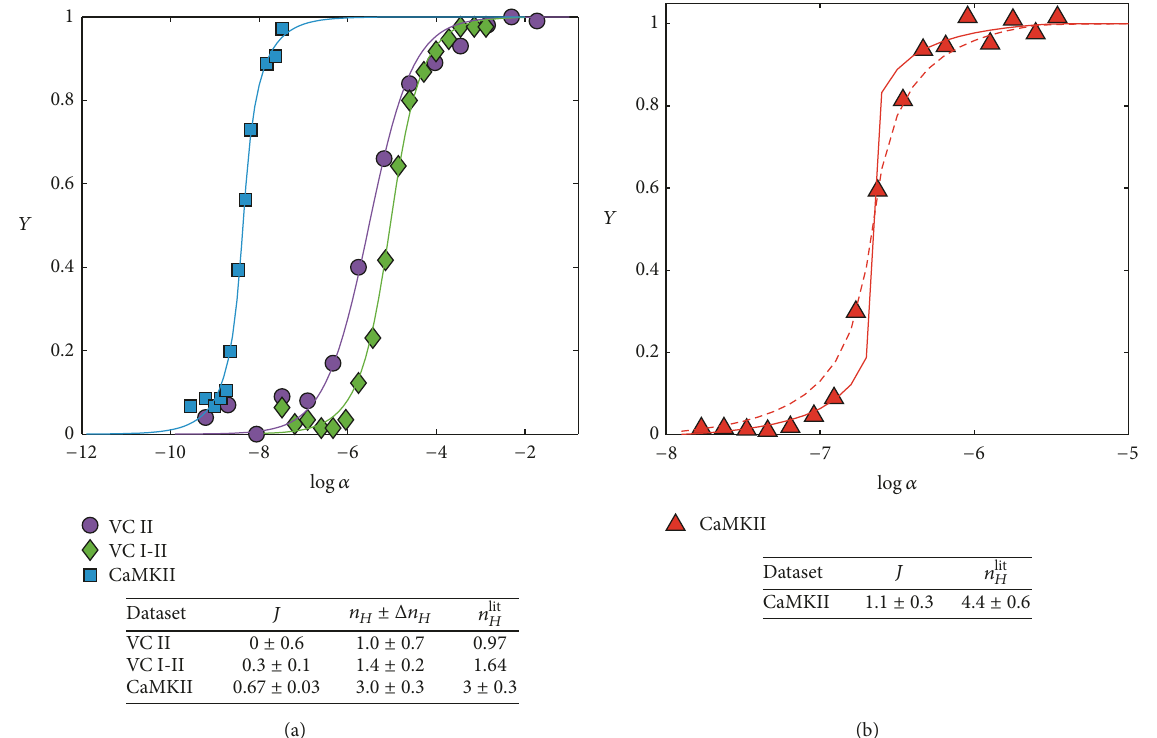
Figure 1: These plots show comparison between data from experiments (symbols) and best-fits through (22) (lines). Data refer to noncooperative and positive-cooperative systems [33, 34] (a) and an ultrasensitive system [35] (b). For the latter we report two fits: dashed line is the result obtained by constraining the system to be cooperative but not ultrasensitive (i.e., 𝐽 ≤ 1 ), while solid line is the best fit (without constraints) which yields to 𝐽 ∼ 1.1 , hence a “first-order phase transition” in the language of statistical mechanics. The relative goodness of the fits is 𝑅 2 coop ∼ 0.85 and 𝑅 2 ultra ∼ 0.94 , confirming an ultrasensitive behavior. The tables in the bottom present the value of 𝐽 derived from the best fit and the resulting 𝑛 𝐻 according to (24); the estimate of the Hill coefficient taken from the literature is also shown for comparison. This figure was presented in